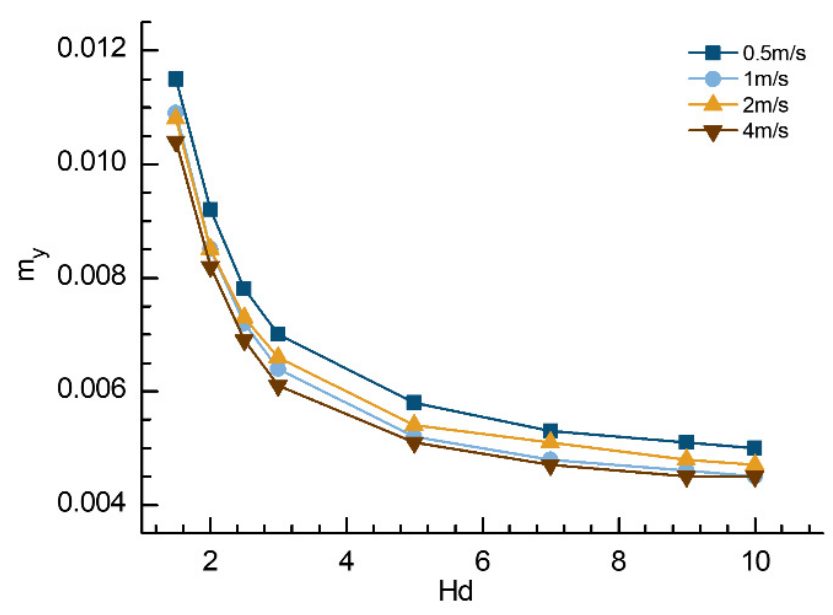
Figure 13. Self-propelled UUV Pitch moment characteristics.